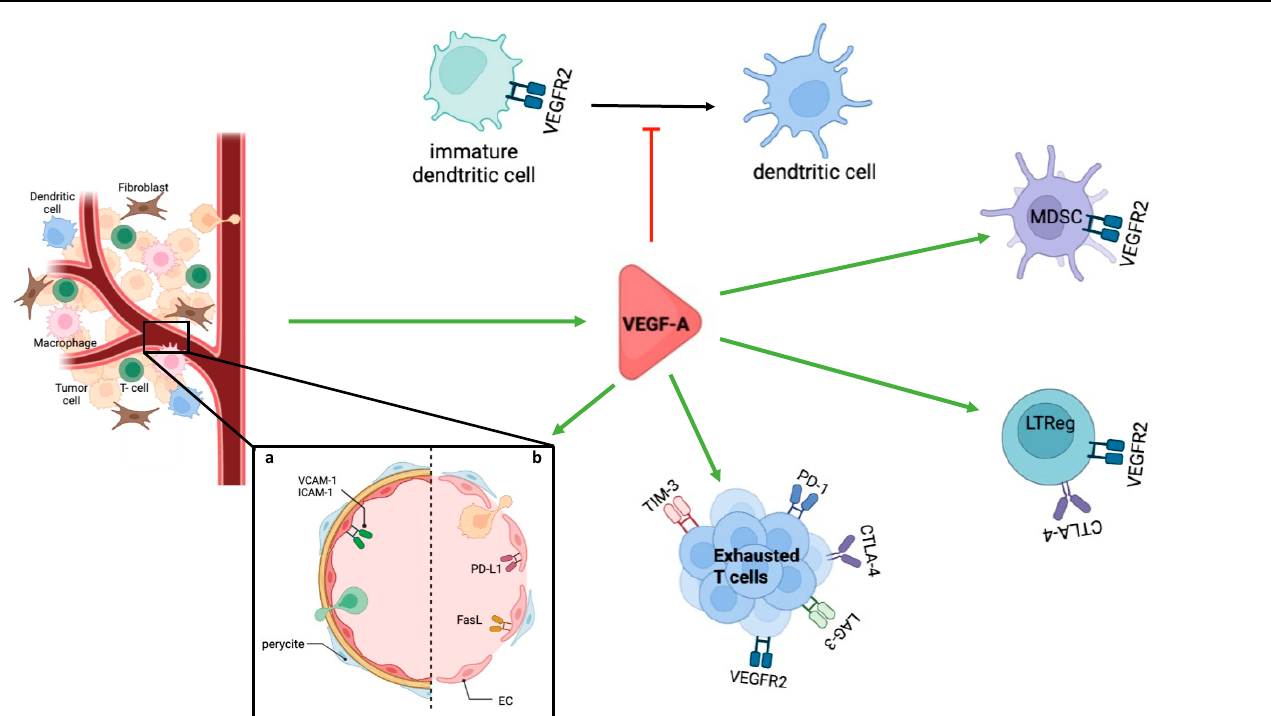
Figure 3. Immunosuppression role of VEGF-A . Different immunosuppressive roles of angiogenesis are presented, either through the immunosuppressive functions of proangiogenic factors such as VEGF-A or through the immunosuppressive functions of the tumour blood vessels. a. illustrates the structure of normal blood vessels when activated with TNF- α which favours infiltration of immune cells, b. illustrates tumour blood vessels with altered structure and examples of immunosuppressive functions by expression of immunosuppressive molecules.